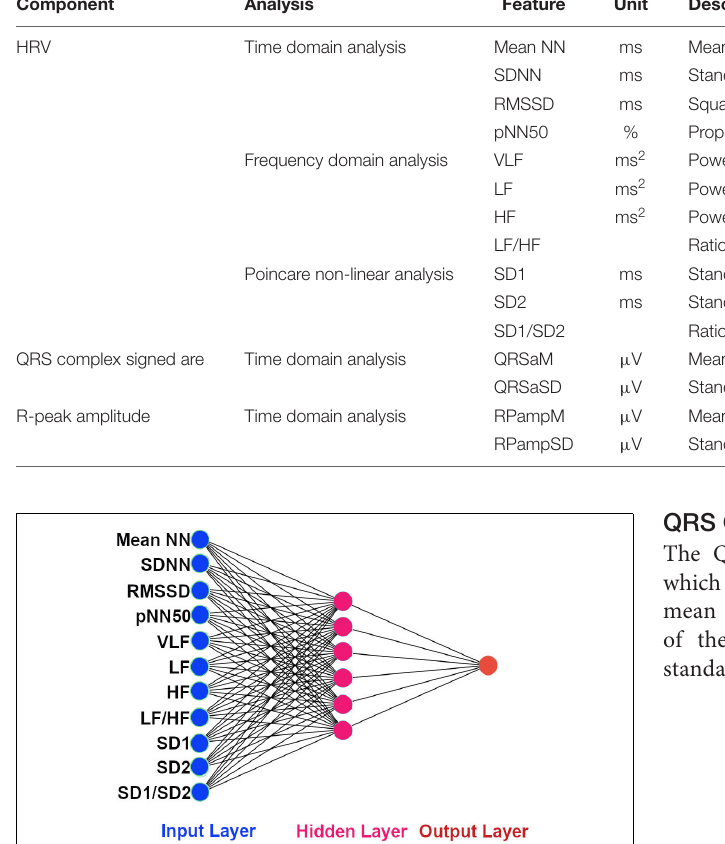
TABLE 1 | Features extracted from the HRV, the QRS complex singed area, and the R-peak amplitude. Component